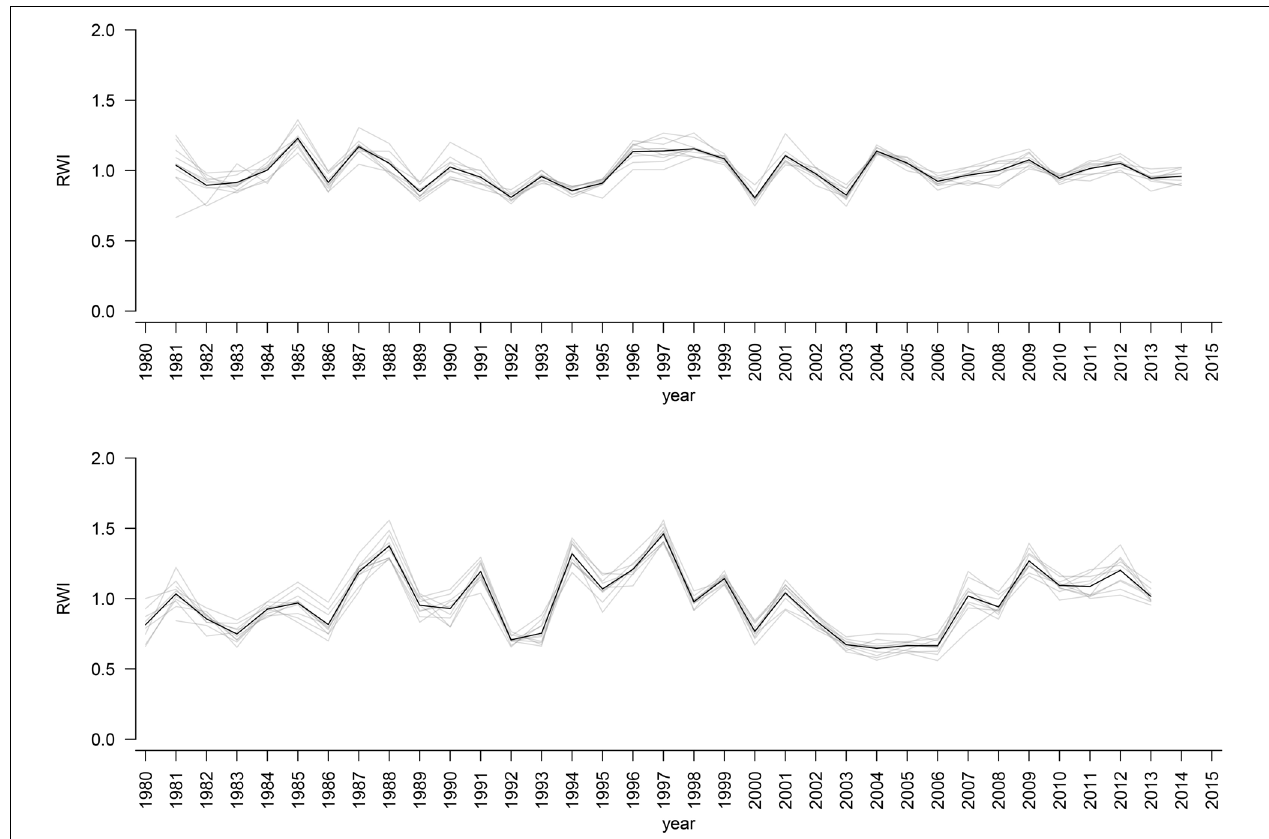
FIGURE 4 | RWI provenance chronologies for KN site (upper plot) and KR site (lower plot). Black bold line: RWI mean site chronologies.